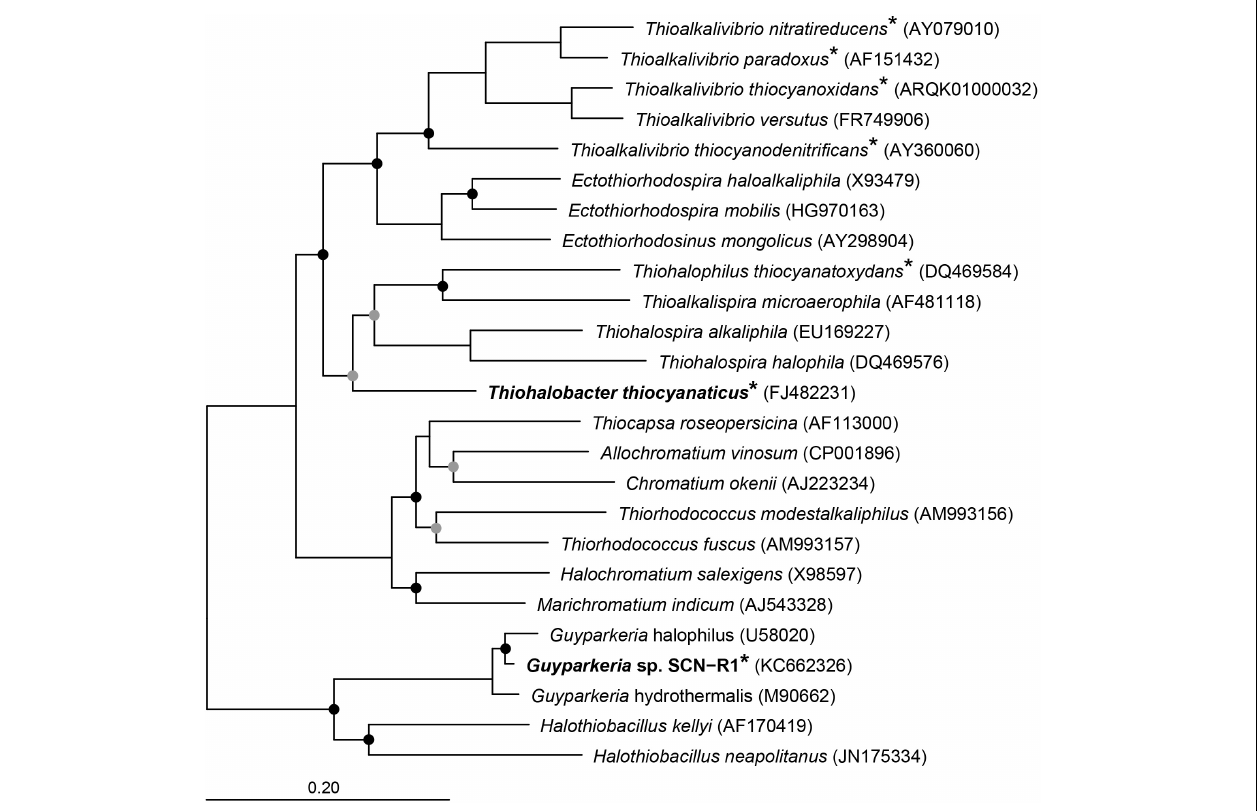
FIGURE 1 | Neighbor joining tree based on 16S rRNA sequences showing the phylogenetic affiliation of Thiohalobacter thiocyanaticus and Guyparkeria sp. SCN-R1 in comparison to other sulfur and/or thiocyanate-oxidizing species of the Gammaproteobacteria. Species that have been demonstrated to oxidize thiocyanate are indicated by an asterisk. The circles on the nodes indicate bootstrap values between 100–75% (black dots) and between 75–50% (gray dots) out of 1000 iterations. The scale bar indicates sequence differences. Sequences of different members of the Thermotogales were used as an outgroup, but were pruned from